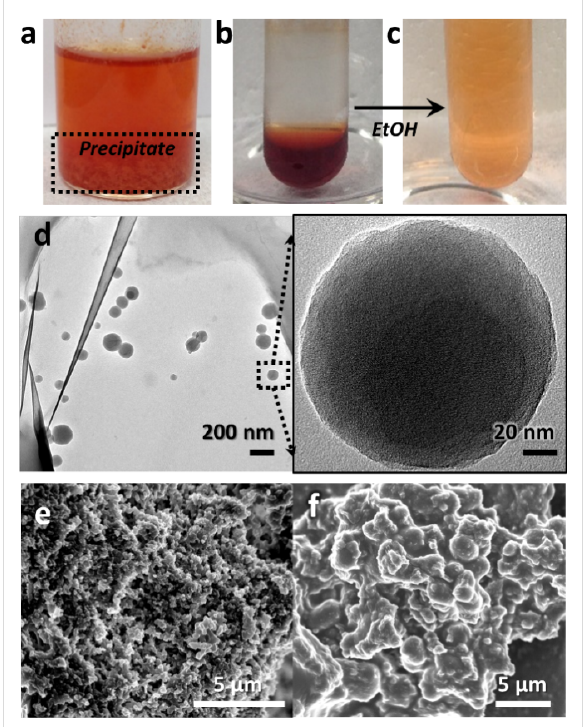
Figure 3: Effect of amine equivalence in solubilizing COP-100. (a) COP-100 dissolved in 8 equivalent EDA which precipitated by the addition of ethanol, (b) COP-100 dissolved in 50 equivalent EDA, and (c) diluted solution of (b) in ethanol. (d) TEM image of COP-100-NP obtained from the solution (b). SEM image of COP-100 precipitates after the addition of (e) 5 equivalent EDA and (f) 8 equivalent EDA.